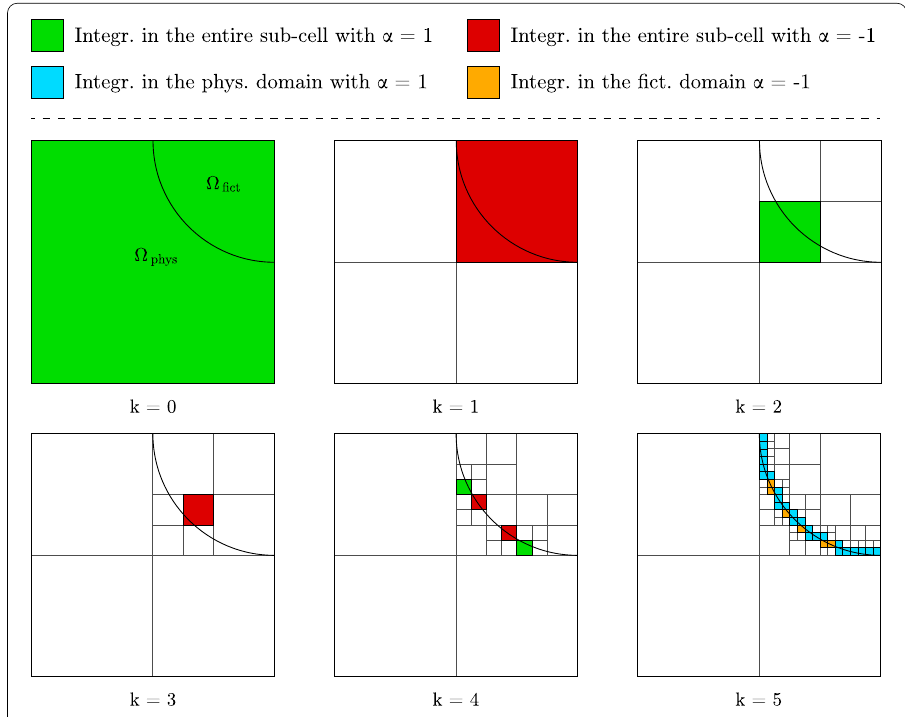
Fig. 16 Illustration of the integration sub-cells resulting from the B-QTD. On each refinement level a certain number of sub-cells is created and different labels are assigned indicated by the color-coding: The sets of ) and red sub-cells ( B − ) represent integration domains where the discontinuity is not taken into green ( B + full full account. The blue ( B + cut ) and orange ( B − cut ) sub-cells are located at k = k max = 5 exclusively, and they denote integration domains, where the discontinuity is actually taken into account, but only IPs in the physical (blue) or fictitious (orange) domain are